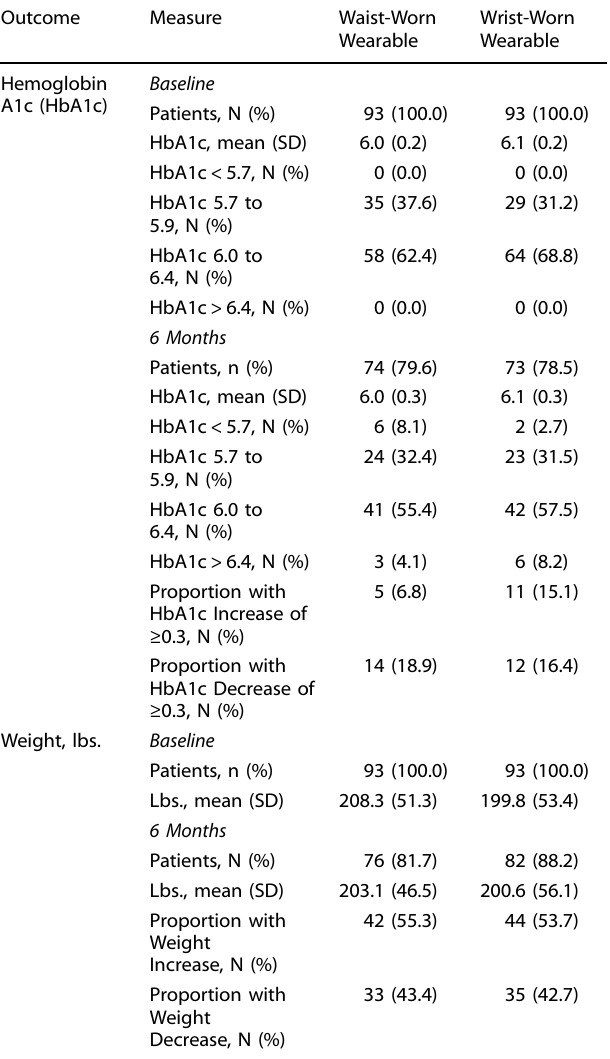
Table 2. Hemoglobin A1c and weight